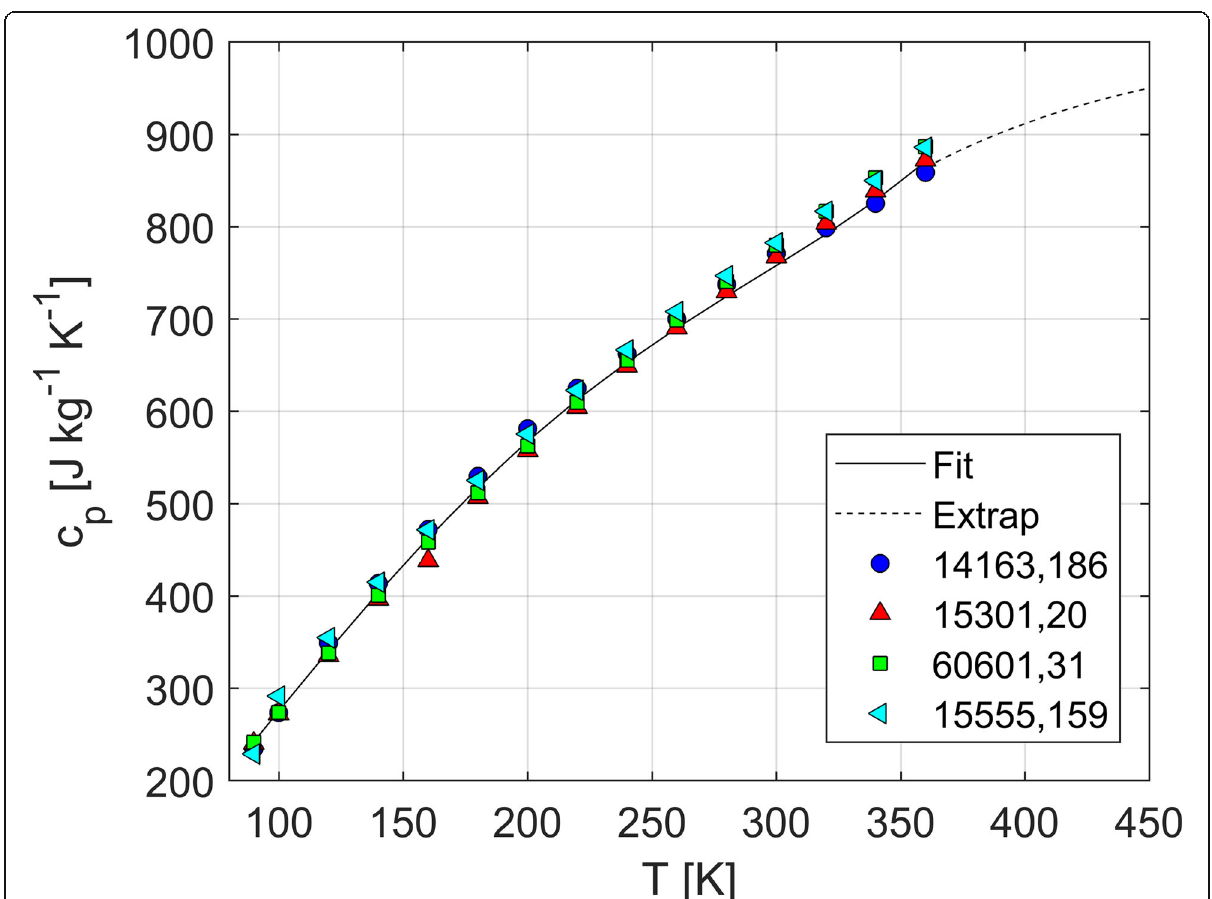
Fig. 7 Specific heat capacity of lunar samples 14,163,186 (fines > 1 mm, blue circles), 15,301,20 (soil, red triangles), 60,601,31 (soil, green squares), and 15,555,159 (basalt, cyan left triangles) as a function of temperature together with the best fitting curve (solid line) as well as an extrapolation for temperatures beyond 350 K (dashed line). Data and fit from Hemingway et al. (1973), extrapolation from Ledlow et al.